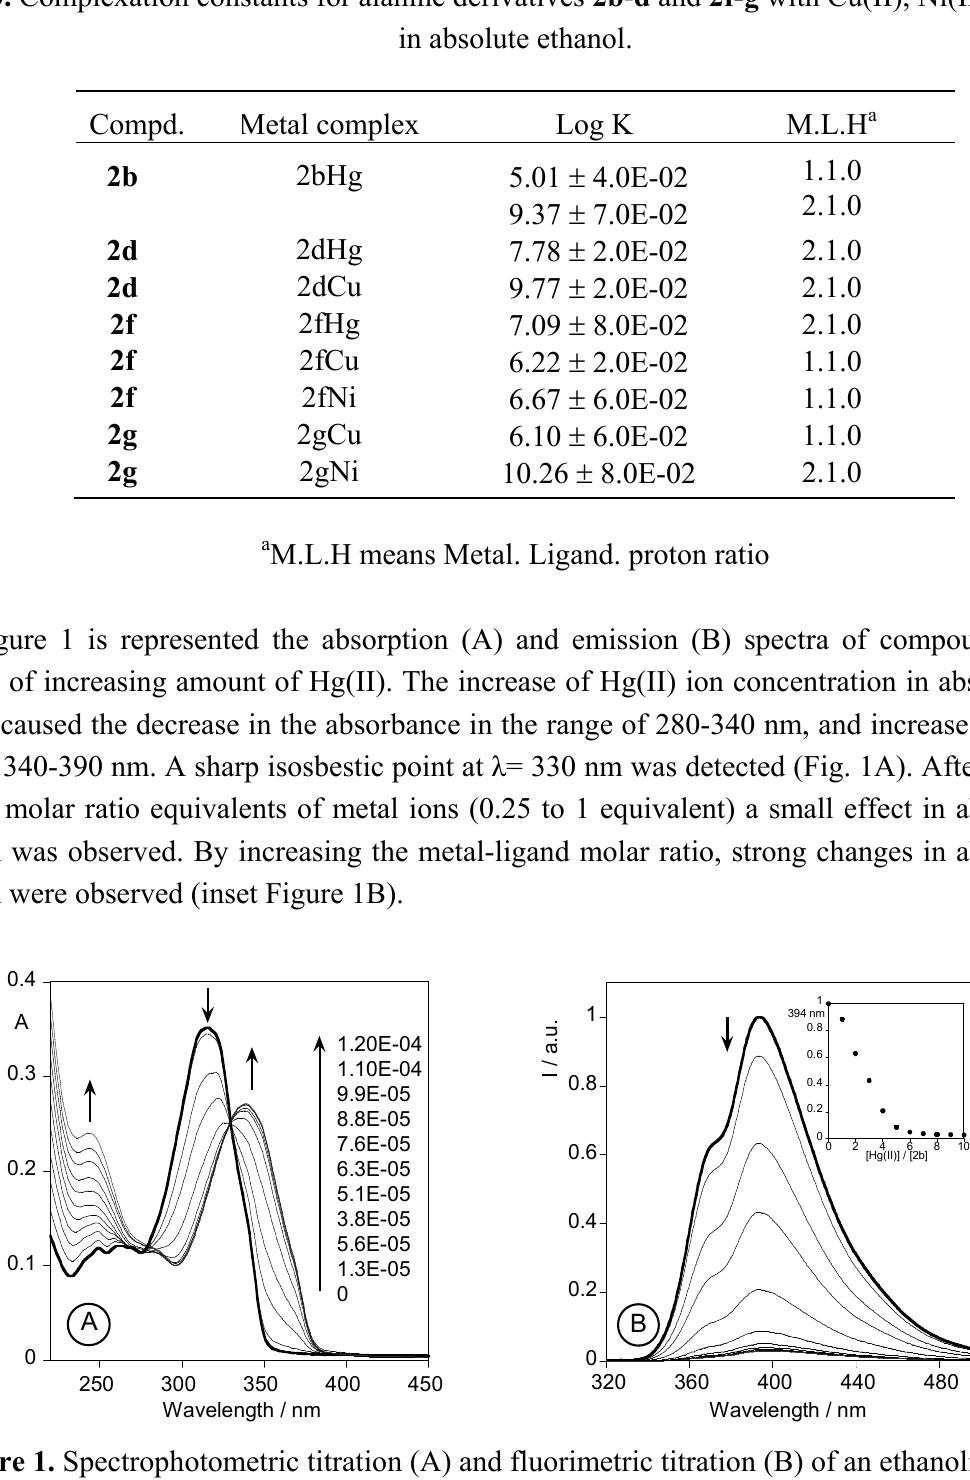
SO ) in absolute ethanol ([ 2b ] = 1.30E-5 M, T = 298 K, λ 3 2 2 316 nm. Inset: normalized emission at 394